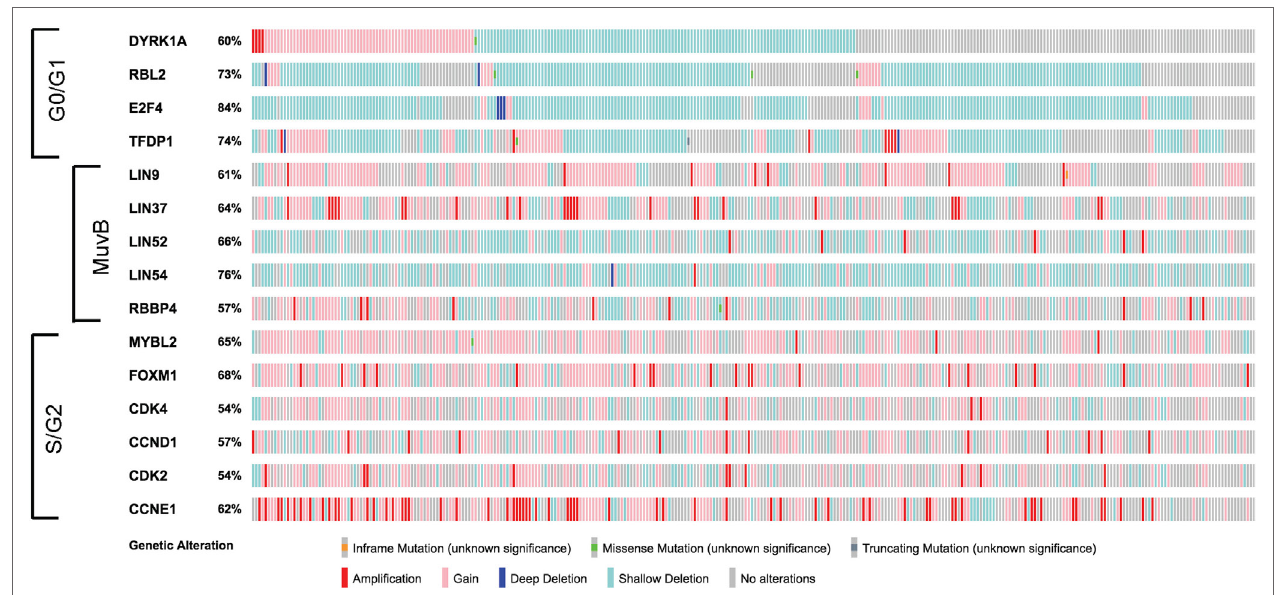
FiGURe 2 | Alterations in genes involved in MuvB complex function. Figure shows summary of copy number alteration and mutation data from high-grade ovarian carcinoma samples ( N = 316) visualized using cBio.org resource (19, 23). Note that the factors required for the G0/G1 function of the MuvB more frequently undergo genetic losses (blue color), whereas regions encoding genes associated with MuvB in S/G2 are frequently gained (pink) or amplified